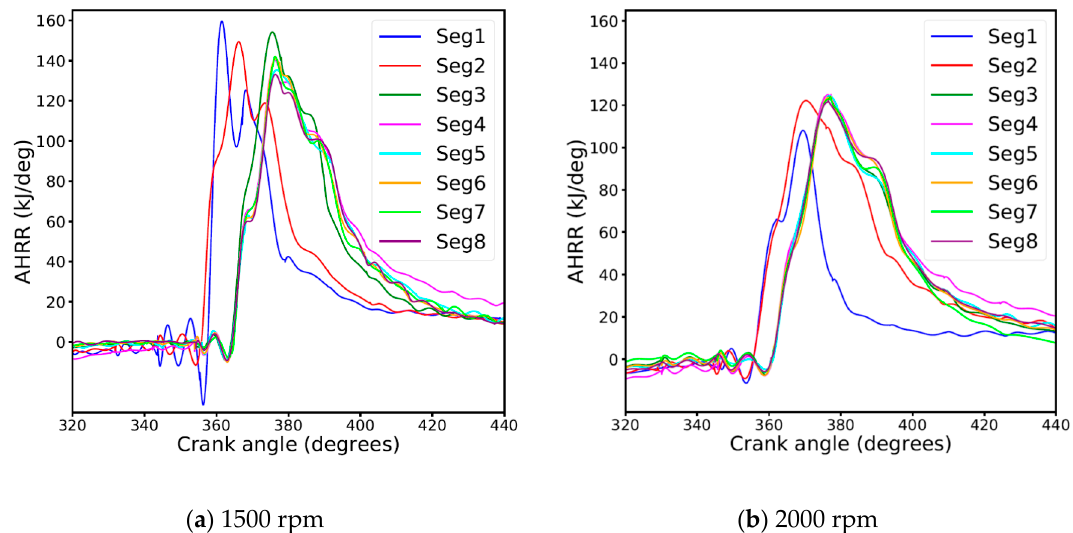
Figure 5. Apparent Heat Release Rate (AHRR) at 100% load in each segment in all stages at ( a ) 1500 rpm and ( b ) 2000 rpm. The blue line represents Segment 1, red line represents Segment 2, green line represents Segment 3, magenta line represents Segment 4, cyan line represents Segment 5, orange line represents Segment 6, lime line represents Segment 7 and purple line represents Segment